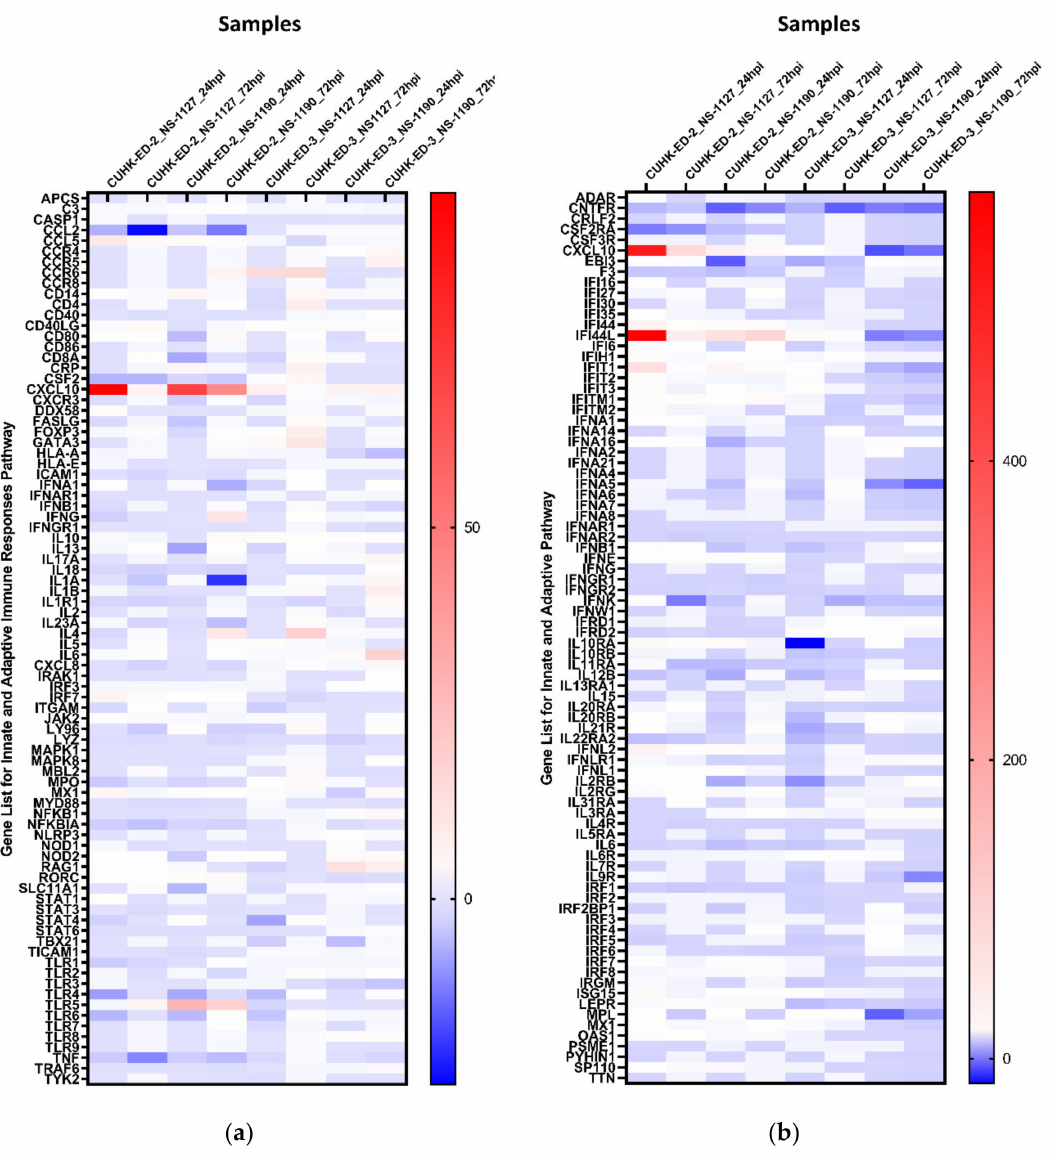
Figure 3. Heat maps showing the regulation of genes expression within each inoculation against 1 hpi of ( a ) the “Innate and Adaptive Immunity” pathway and ( b ) the “Human Interferon and Receptor” pathway: a gradient of blue to red was used to indicate the fold change obtained. Red colour illustrates an upregulation of the genes, whereas blue colour represents a downregulation of genes with reference to baseline samples at 1 hpi. All samples are associated with productive HuNoV replication except CUHK-ED-3 inoculated with